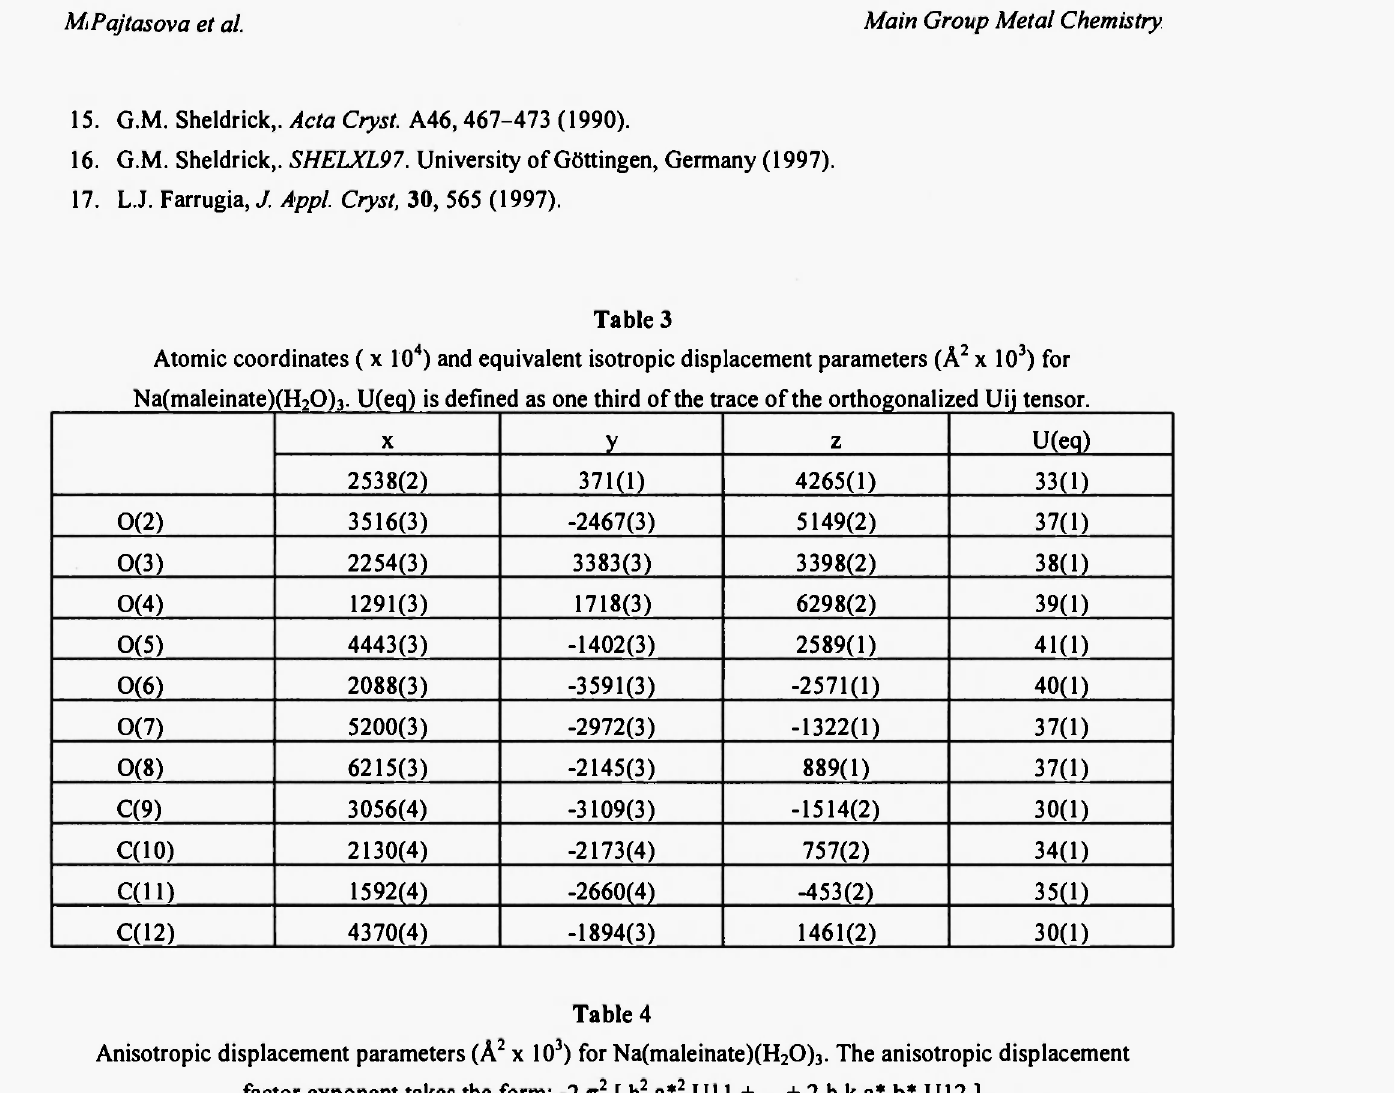
Anisotropic displacement parameters (Α 2 χ 10 3 ) for Na(maleinate)(H 2 0) 3 . The anisotropic displacement factor exponent takes the form:-2 π 2 [h 2 a* 2 Uli + ... + 2 h k a* b* U12